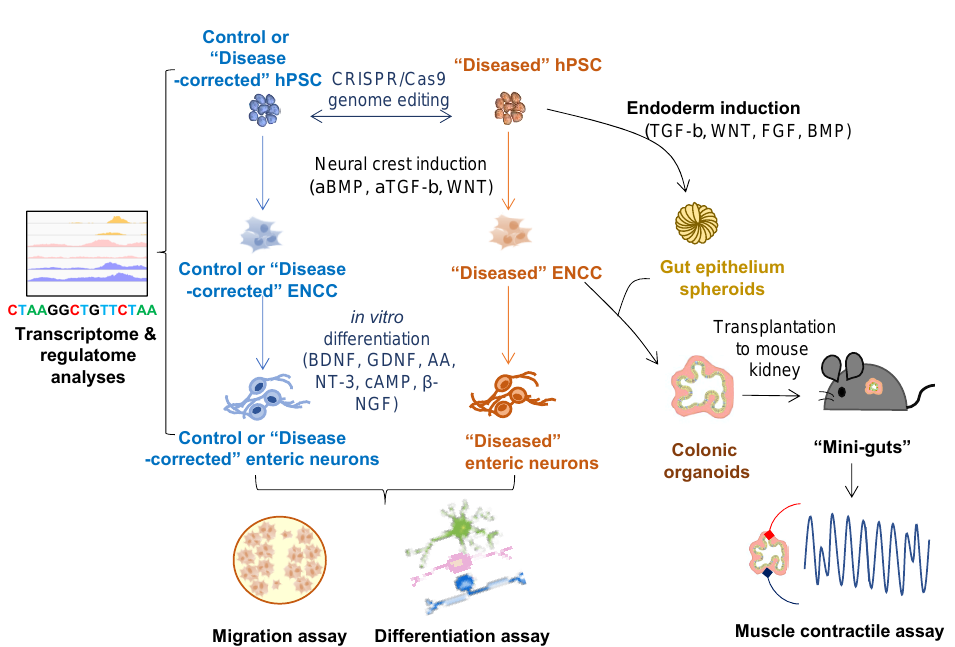
Figure 2. Applications of hPSC-derived 2-D and 3-D cell models of ENS on studying HSCR disease. ENCC-like cells and intestinal organoids are derived from hPSCs by manipulating different devel- opmental cues (BMP, TGF-b, WNT, and FGF). Innervated “mini-gut” are generated by combining the intestinal organoids with the ENCCs and engrafted to the mouse kidney capsule for further maturation. The 2-D cell models (ENCCs and enteric neurons) can be used for multi-omics studies (e.g., transcriptome and regulatome analyses) and functional assays (e.g., migration and in vitro differentiation assays). The 3- D cell models (colonic organoids and “mini - guts”) can be used for